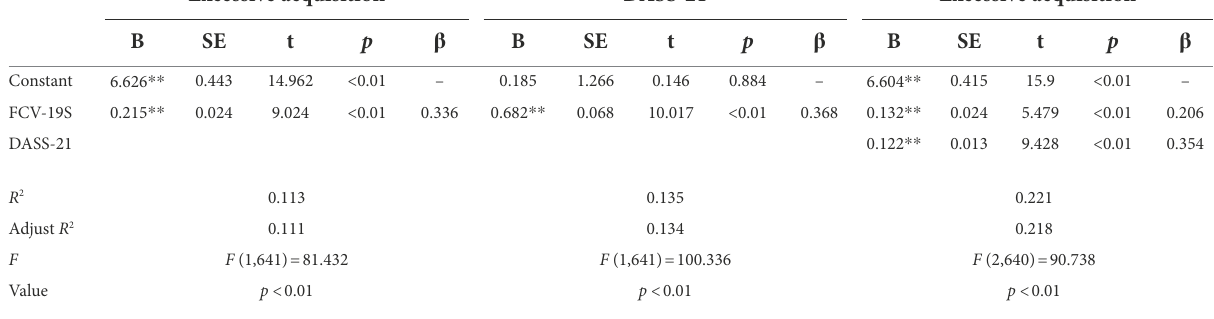
TABLE 5 Results of mediation analysis (excessive